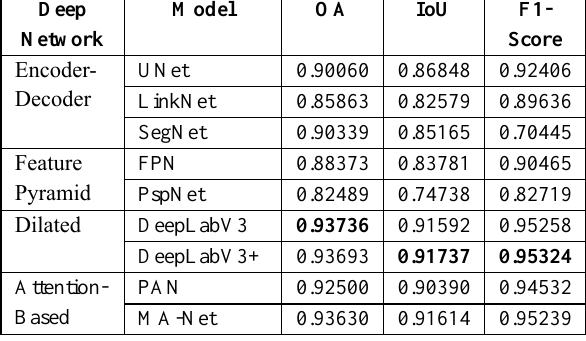
Table 1 . Comparison of different segmentation architectures on the test datasets.